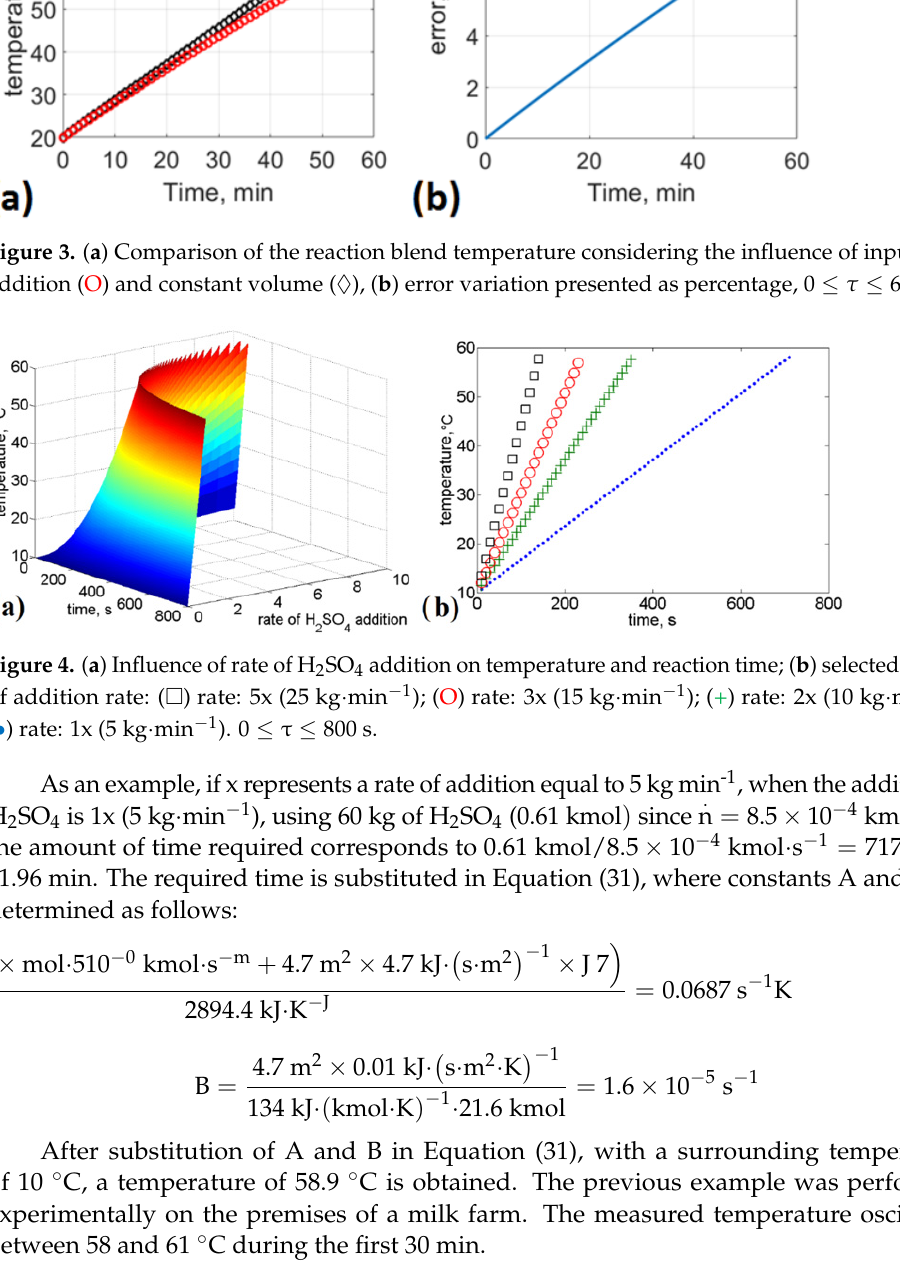
Figure 4. ( a ) Influence of rate of H 2 SO 4 addition on temperature and reaction time; ( b ) selected values of addition rate: ( □ ) rate: 5x (25 kg ∙ min − 1 ); ( Ο ) rate: 3x (15kg ∙ min − 1 ); (+) rate: 2x (10kg ∙ min − 1 ); ( ● ) rate: 1x (5kg ∙ min − 1 ). 0 (cid:3409) 𝜏 (cid:3409) 800 s .